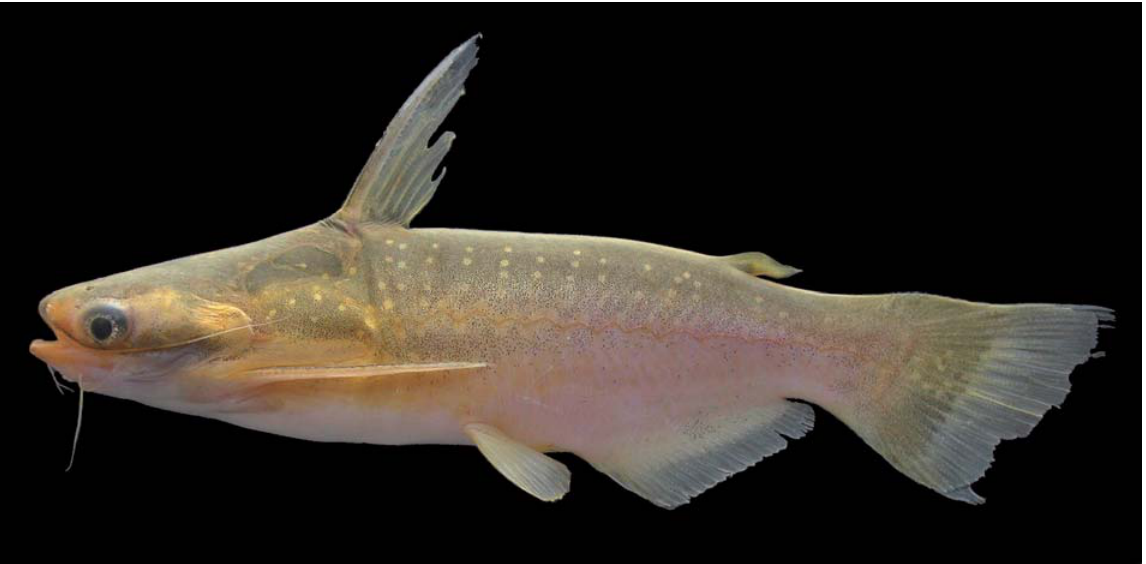
Fig. 2. Auchenipterichthys coracoideus , life coloration, ANSP 178446, 94 mm SL, Río Nanay, at Pampa Chica, village 4.54 km W of Iquitos (3°45’09"S, 73°17’00"W). Basal adipose fin spot not readily evident in this photograph, but can be seen in